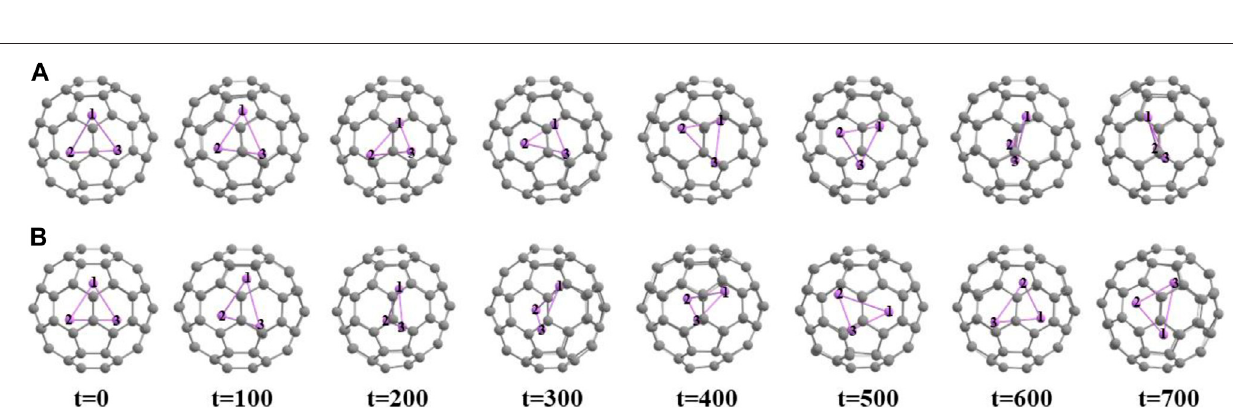
molecular orbital (HOMO), HOMO-1, and lowest unoccupied molecular orbital (LUMO) for the systems are presented in Figure 6 . For the Li 3 @B 40 system, the HOMO-1 and LUMO are distributed over the B 40 cage but there is no contribution from the Li 3 moiety. For the Li 3 @C 60 system, the HOMO and LUMO are π -type of orbitals and are distributed over the C 60 cage but there is no contribution from the Li 3 moiety. The energy differences between HOMO and LUMO are 0.62 eV and 0.18 eV for Li 3 @B 40 and Li 3 @C 60 systems, respectively. The spin density plots are presented in Figures 6C,D for Li 3 @B 40 and Li 3 @C 60 system, respectively. The spin density plots show that the total spin density is distributed over the guest Li 3 cluster and the host B 40 and C 60 cages.